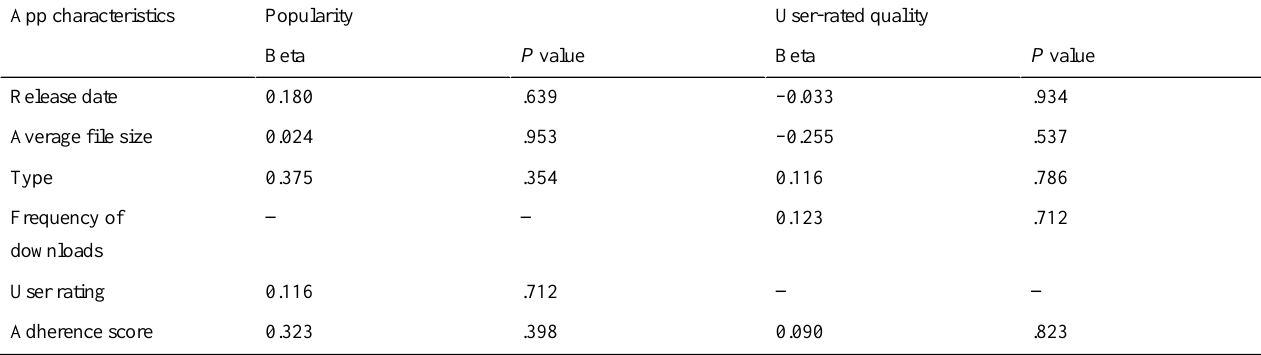
Table 2. Regression analysis of app characteristics on app popularity and user-rated quality